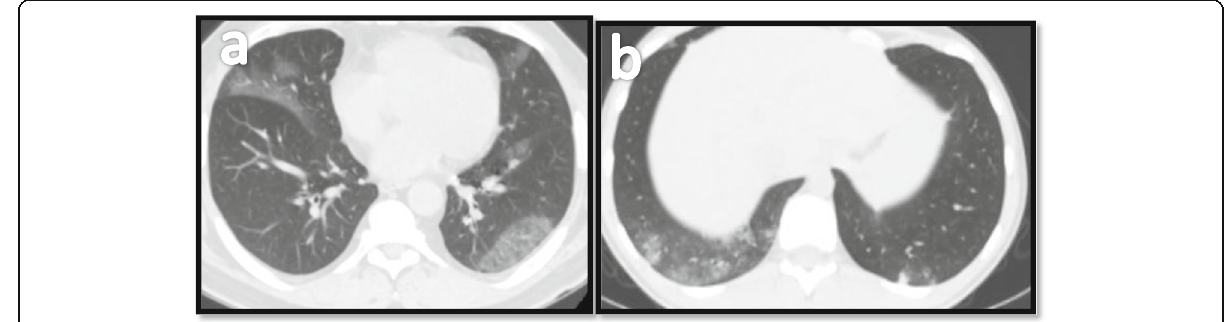
Fig. 4 MSCT scan for two asymptomatic patients. a 33-year-old male patient with recent travel history showing bilateral variable-sized patchy GGO seen affecting middle lobe, left lower lobe, and lingua being peripheral sub-pleural in location. b 41-year-old female patient giving a history of close contact to +ve PCR COVID-19 patient showing bilateral lower lung lobes small GG nodular opacities predominantly at the